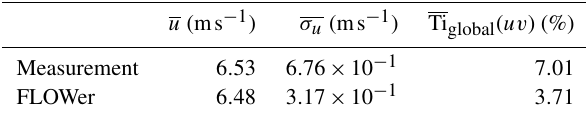
Table 6. Mean parameters for the velocity plane 0 . 5 d downstream of the rotor